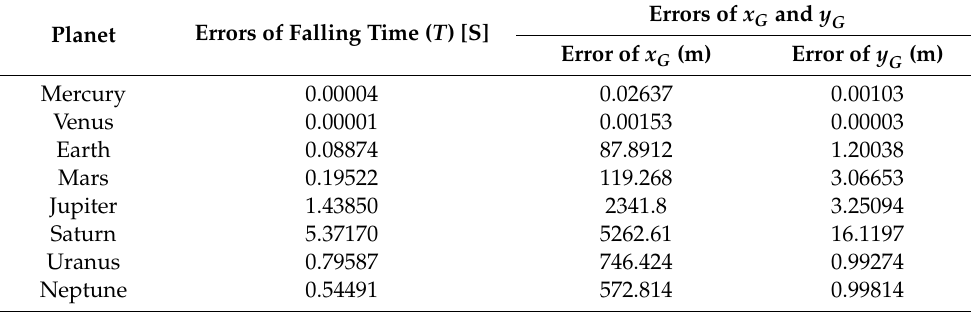
Table 6. The obtained errors of the falling time T , x G , and y G for all planets in the Solar System at the release point Q(50,50,50) (km) when λ = π